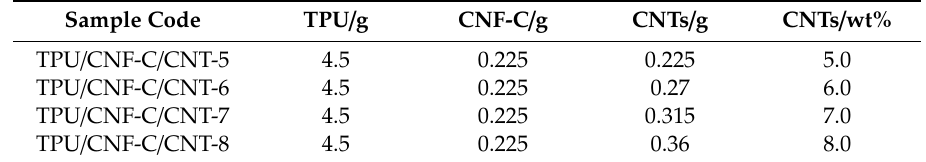
Table 1. Composition of the control sample and as-fabricated TPU / CNF-C / CNTs nanocomposites. Sample